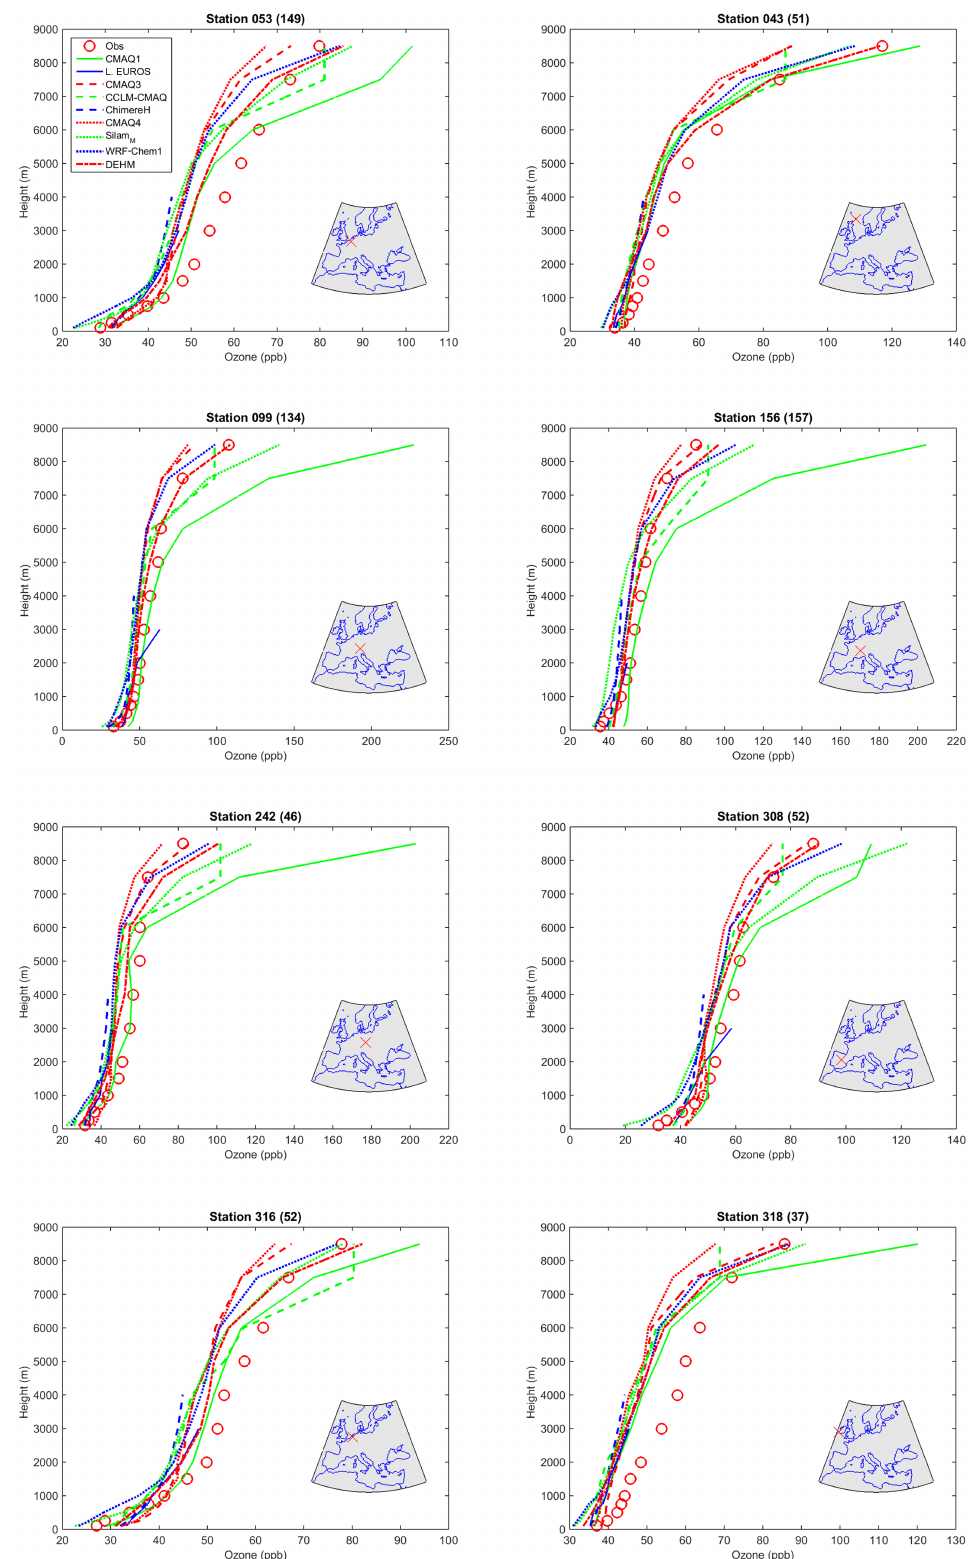
Figure 19. Ozone mixing-ratio profiles measured by ozonesondes launched from the European location indicated in the inset map (lower- right corner) of each panel. The profiles are time averaged over the number of hourly records reported in parentheses at the top of each panel. Legend as in the first